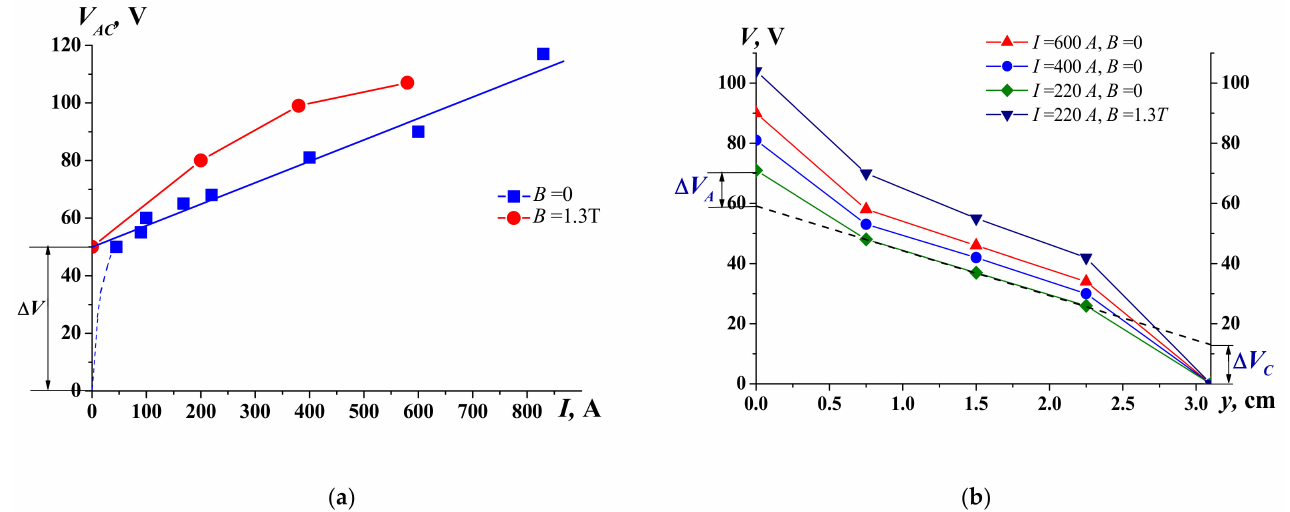
Figure 6. ( a ) Current-voltage characteristic of the discharge in the absence (blue squares) and with the imposition of a magnetic field (red circles); ( b ) Potential distribution in the interelectrode gap at different currents in the circuit.